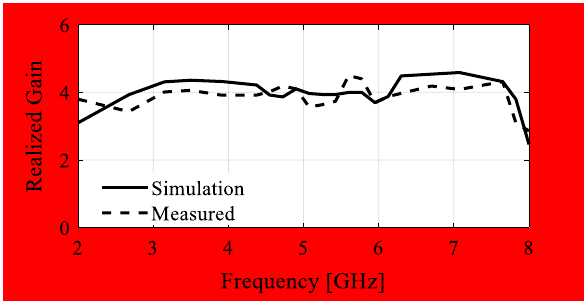
Figure 11. Simulated and measured realized gain of the final design (Example 2).